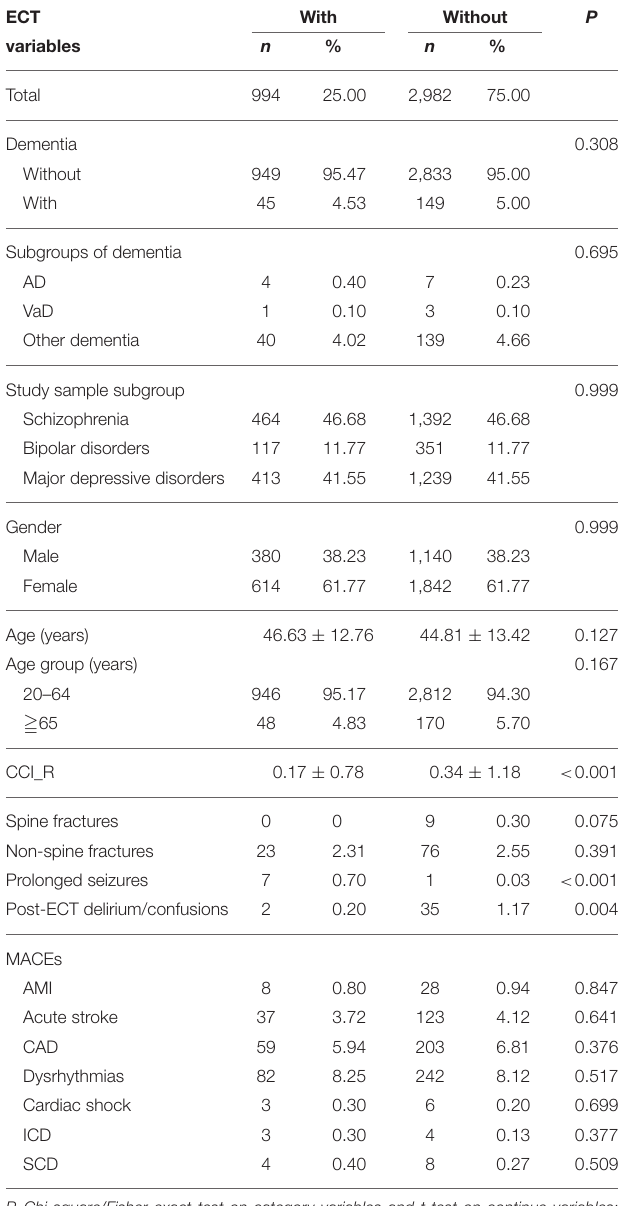
TABLE 2 | Characteristics of study at the end of follow-up. ECT